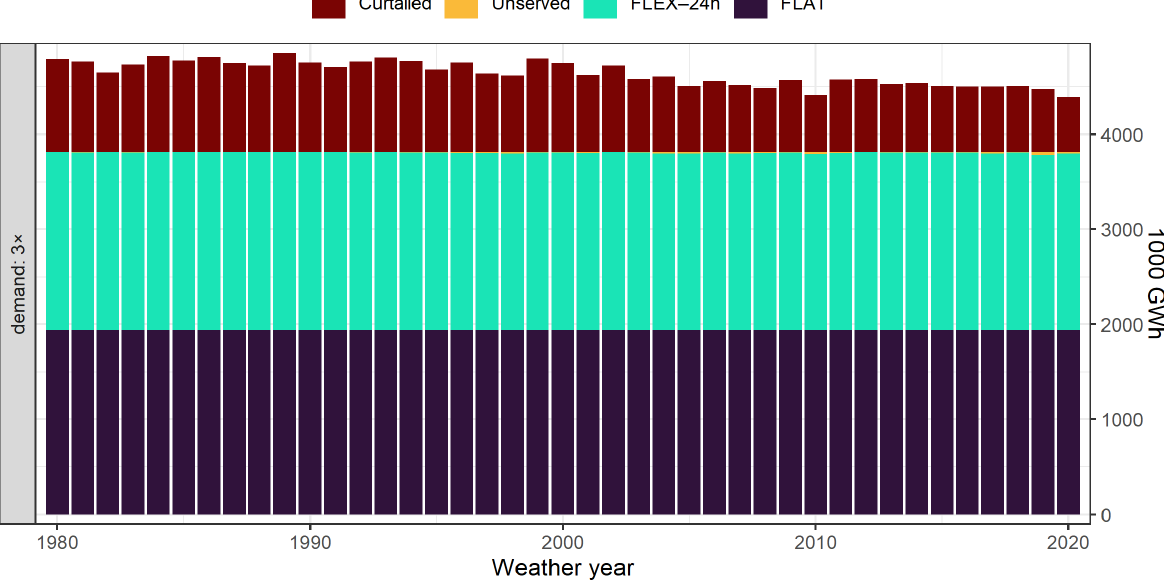
Figure 17. Demand structure by year and curtailed generation.